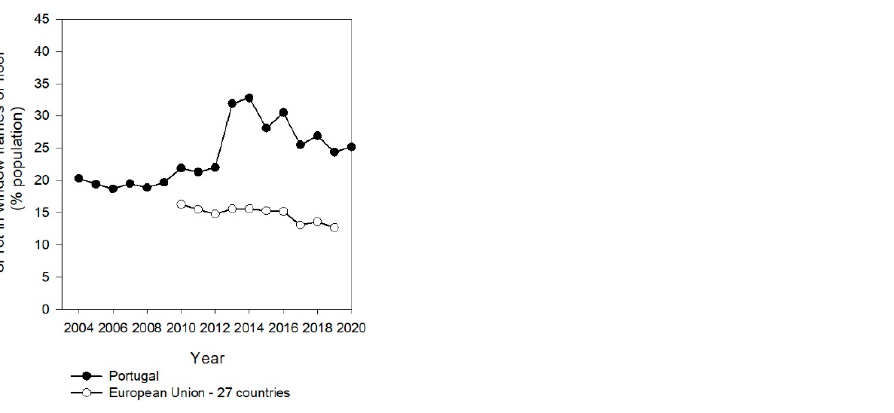
Figure 5. Proportion of inhabitants unable to keep home adequately warm (data source [67]).